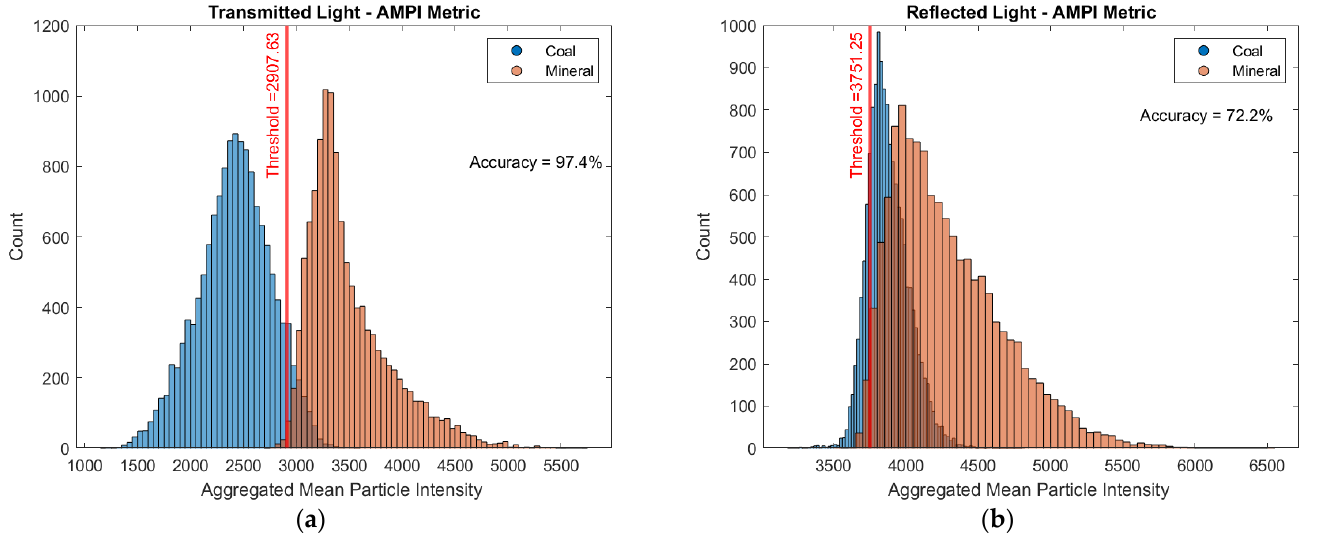
Figure 5. Added mean particle intensity (AMPI) distributions for coal and mineral particles in the training datasets using ( a ) transmitted and ( b ) reflected PP and CP image pairs. The distribution includes the same 166,635 particles in both plots, with a lower size limit of 11 pixels.